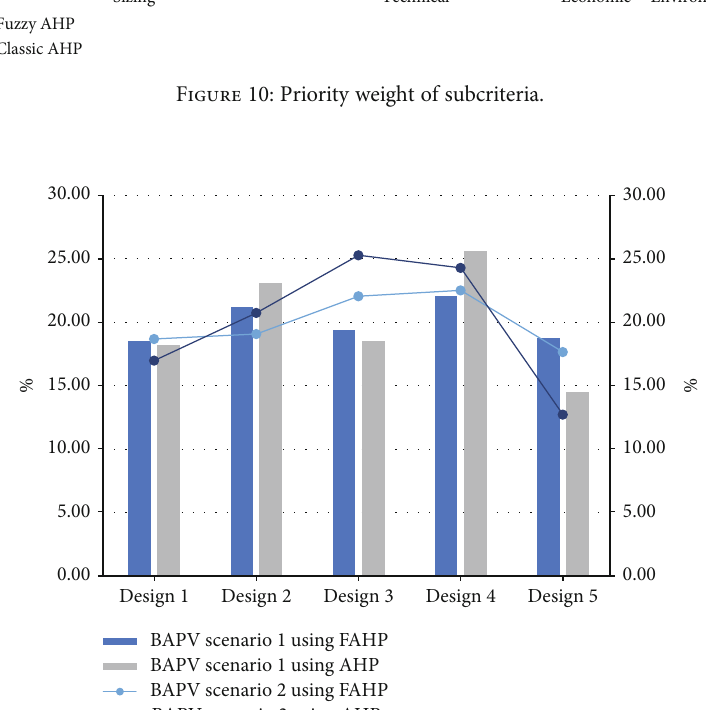
Figure 11: Priority weight of